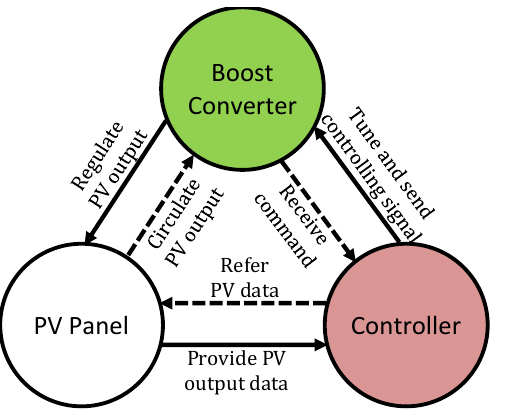
Figure 1. Layout in PV system.